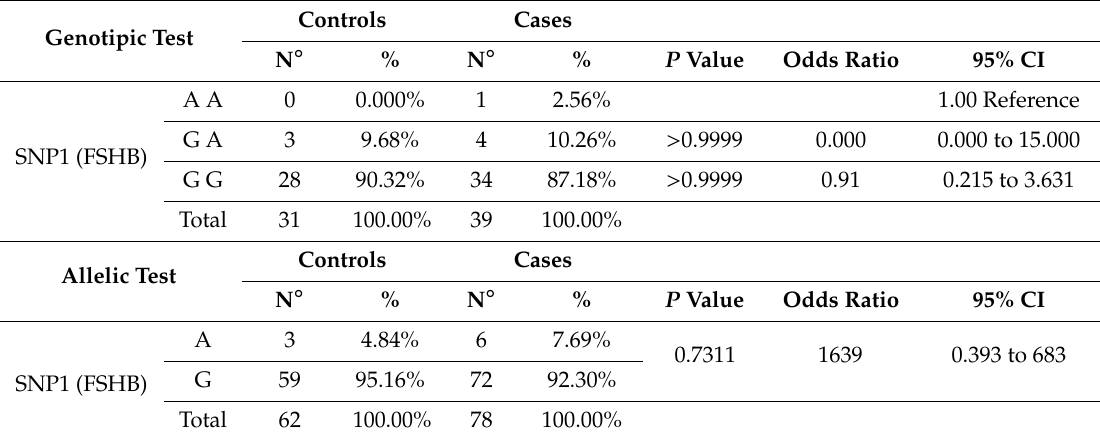
Table 5. Genotypic and allelic frequencies of rs11031006